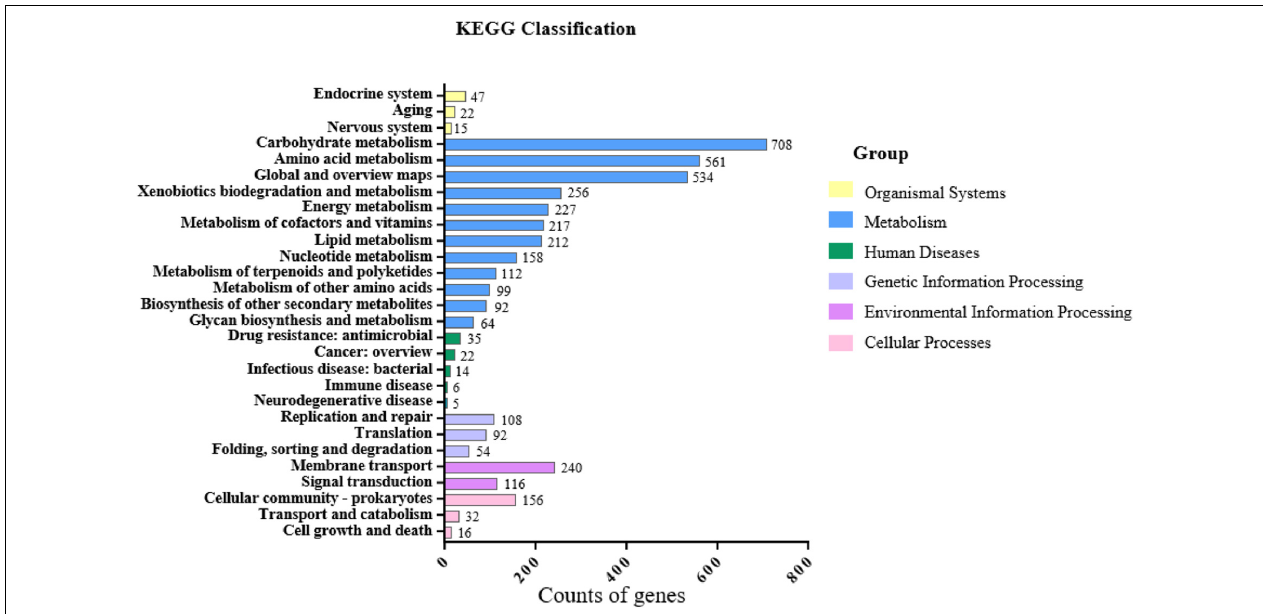
FIGURE 6 | Genomic annotation of S . lincolnensis L4 using KEGG.